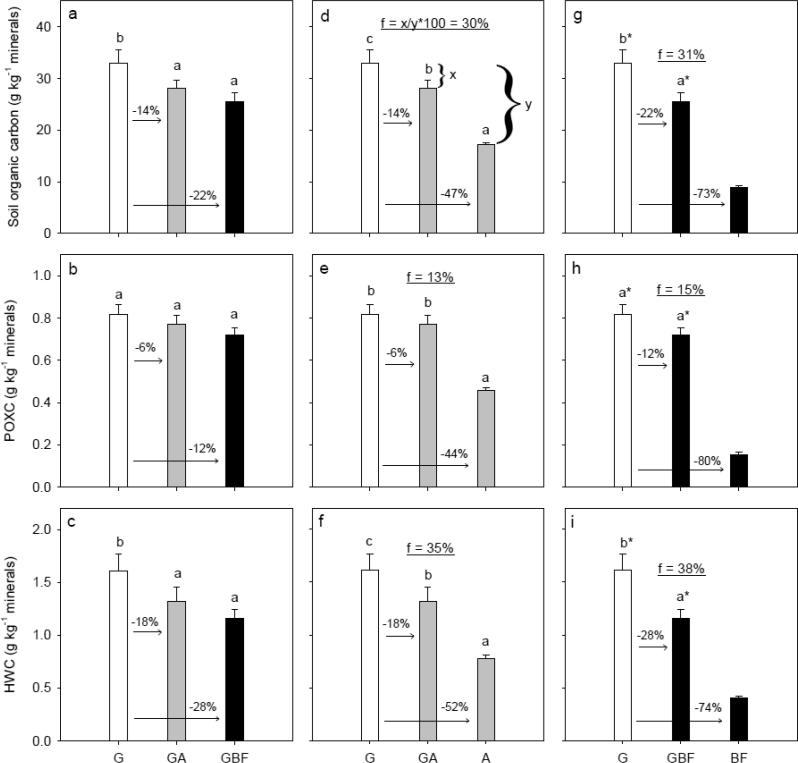
Degradation scenarios: Management system effects on soil organic carbon, permanganate oxidizable carbon (POXC), and hot water-extractable carbon (HWC). White, gray and black bar fills highlight treatments grass, arable and bare fallow, respectively, at time of sampling. Letters denote statistical significance at P < 0.05. An asterisk (*) indicates if BF is significantly different from GBF and G based on a pairwise t-test. The numbers above the arrows denote relative differences. The underlined number in the middle part of the figures denotes the decrease after six years in relation to the long-term decrease, and an example of the calculation is shown in Fig. d. For treatment abbreviations, see Fig. 1.